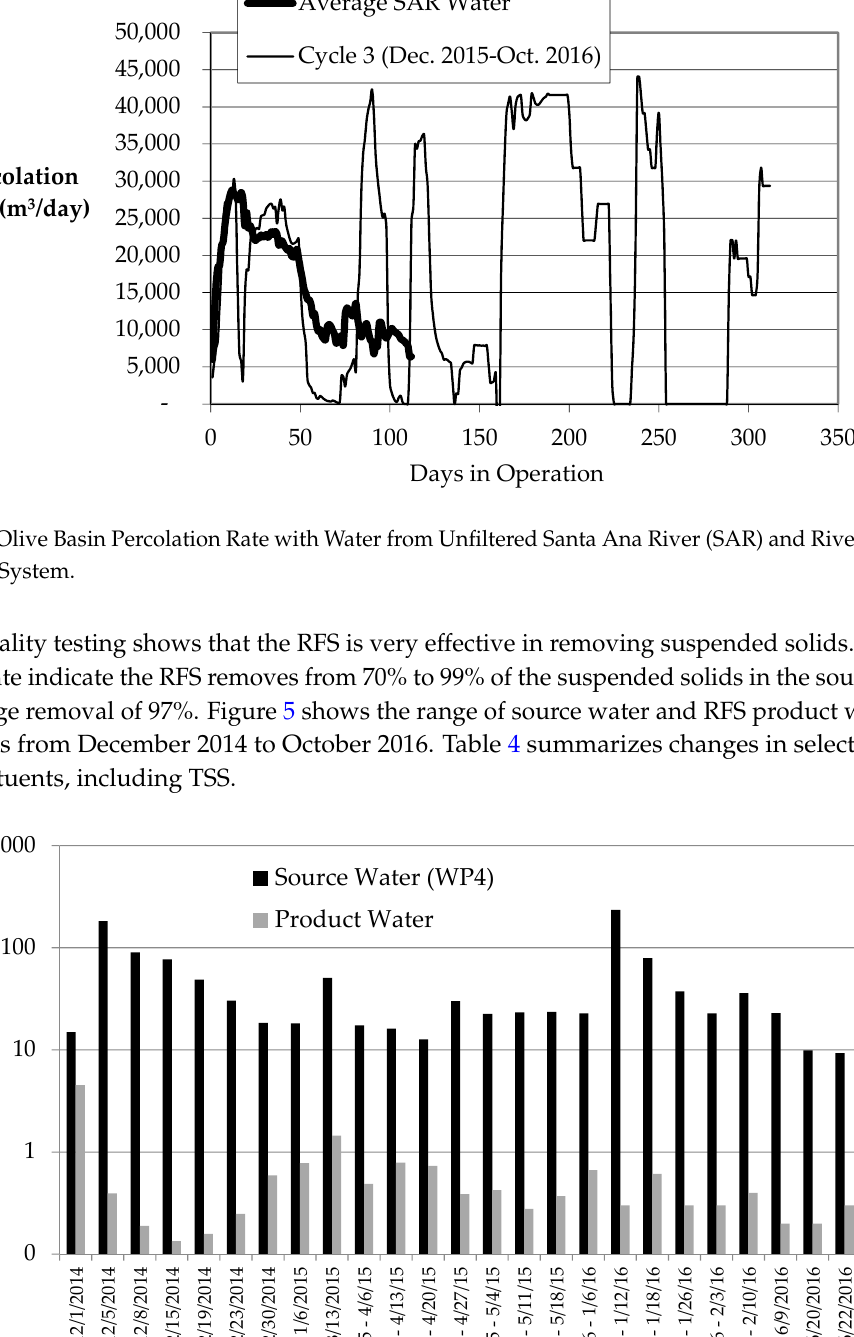
Figure 3. Depth of Water and Flow into Olive Basin.